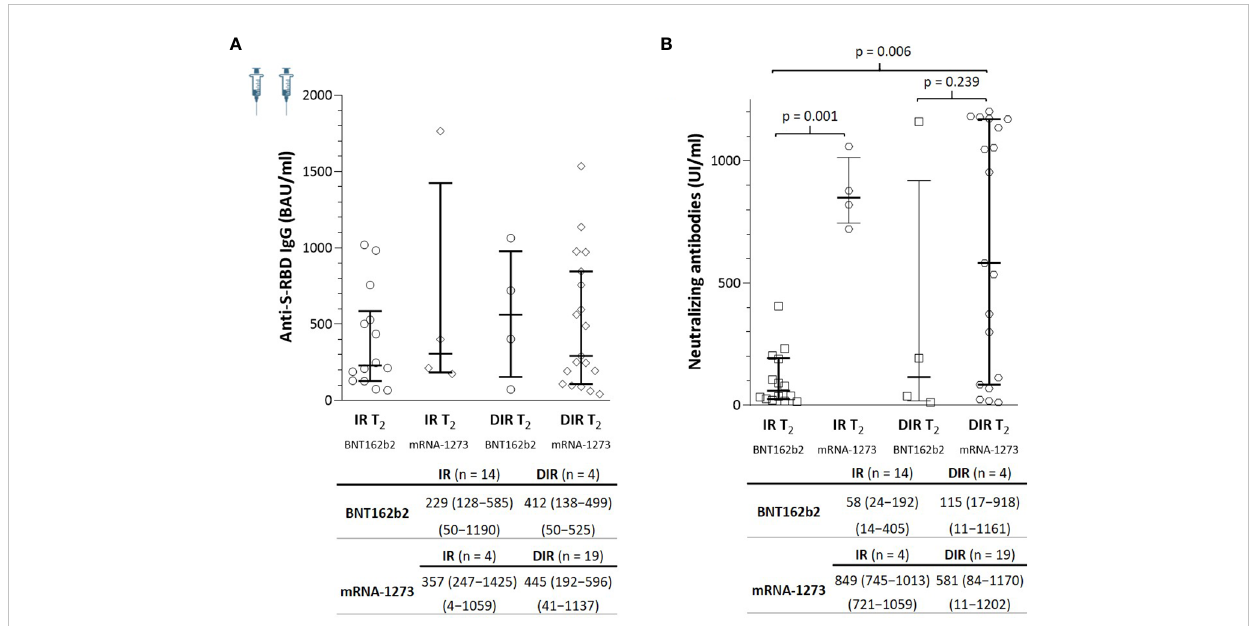
FIGURE 3 (A) Anti-S-RBD IgG and (B) neutralizing antibody titers a median of 5.5 months (T2) after two mRNA vaccine doses according to the group of participants (IR, immune responders. DIR, discordant immune responders) and the vaccine